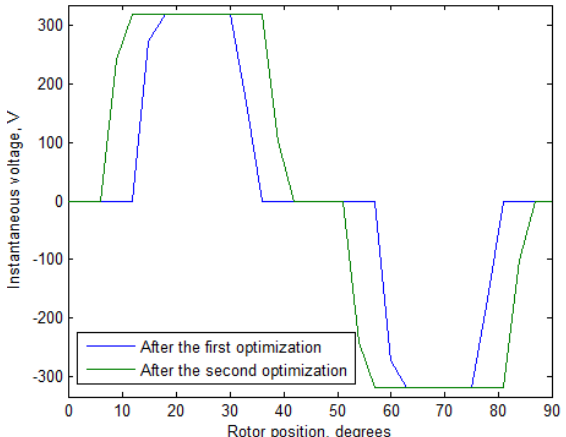
Figure 17. Voltage dependencies on the rotor position in the rated mode before and after the second